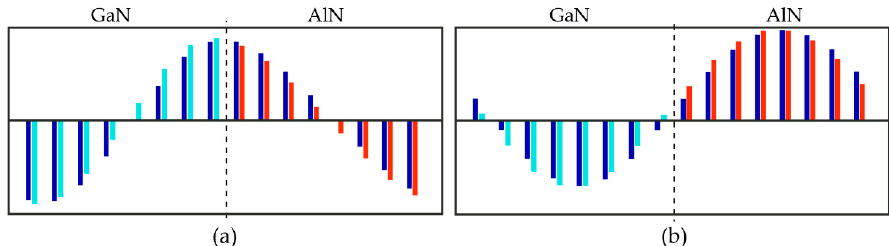
Figure 3. The atomic displacement patterns of longitudinal LA1 ( a ) and LA2 ( b ) phonon modes. Cyan, red, and blue bars denote Ga, Al, and N atomic displacements along the c ‐ axis, respectively.